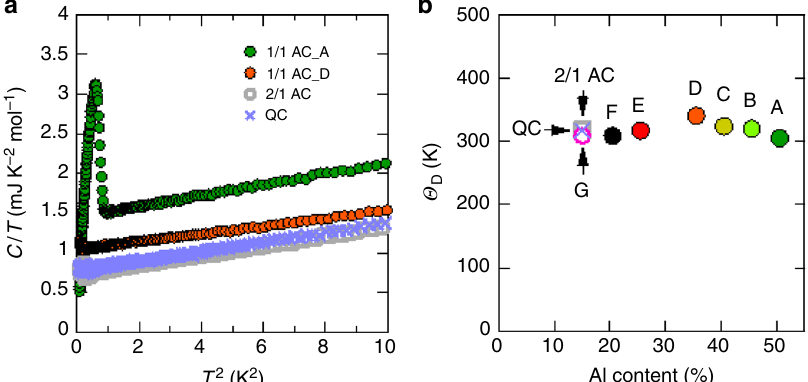
Fig. 5 Speci fi c heat in normal state. a Temperature dependences of speci fi c heat in the form of C = T vs T 2 in the range of 0 < T 2 < 10. The results obtained here are consistent with the data in ref. 15 . Note that all the samples show a conventional form of C T ¼ γ þ β T 2 in the normal state. The peak anomaly at low temperature is due to the onset of superconductivity. b Debye temperature Θ D deduced from β . Note that Θ D is almost independent of Al